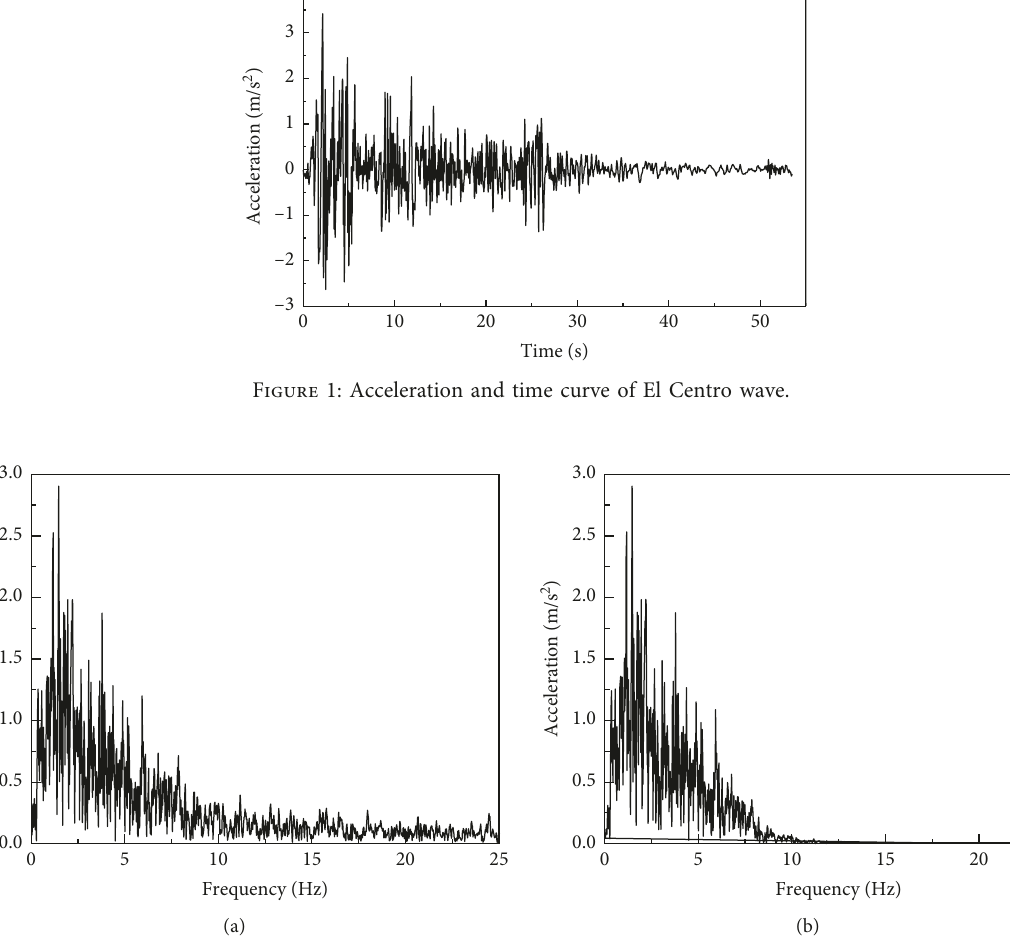
Figure 2: Acceleration-amplitude frequency diagram for the El Centro seismic wave before 27s. (a) Before filtering. (b) After filtering.